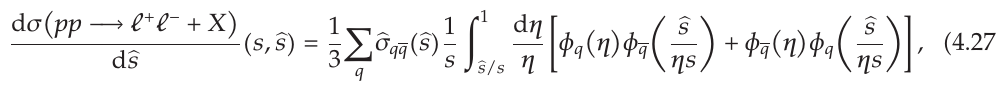
Figure 6: LHC exclusion/discovery reach from pp → μ (cid:9) μ − (cid:9) X as a function of M ρ (cid:8) M (cid:9) M γ (cid:13) (cid:9) M W (cid:13) (cid:9) M Z (cid:13) and of R defined in the text. The curves are obtained by requiring 10 events, for integrated luminosity of 1 , 3 , 10 , 30 , 100 fb − 1 . The darkest region is excluded by indirect limits from light-grey-shaded region is allowed by precision data only for ε < 0 . 5, so that the dominant decay mode of the techni-rho is into longitudinally polarized SM gauge bosons (cid:5) and hence the signal in SM fermions strongly attenuated, or invisible (cid:6) and the large- N approximations used in the analysis performed here do not